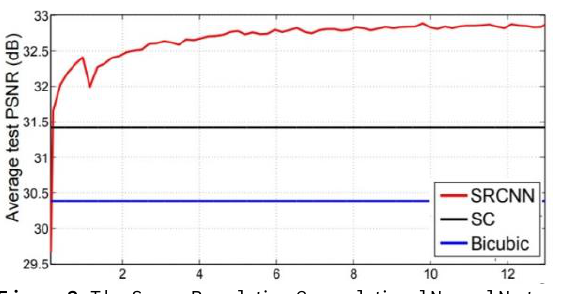
Figure 2. The Super-Resolution Convolutional Neural Network (SRCNN) surpasses the bicubic baseline with just a few training iterations, and outperforms the sparse-coding-based method (SC) with moderate